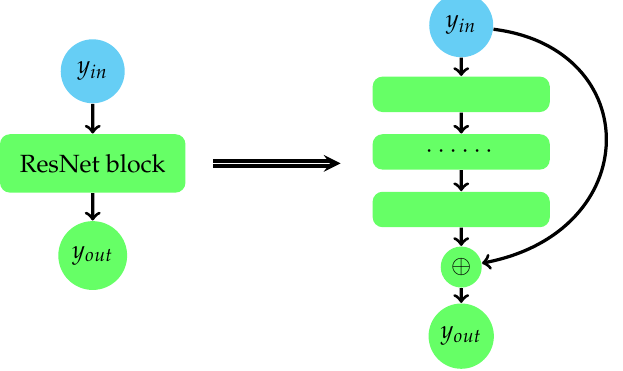
Figure 1. The architecture of